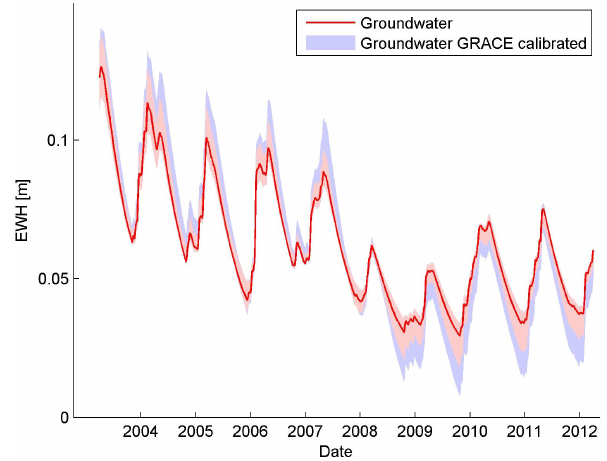
Figure 10. Water mass of groundwater reservoir smoothed over 10days, showing a permanent decline of groundwater between 2007 and 2009. The red line and bandwidth represent the Pareto ensemble based on the NS and log NS of streamflow, while the blue bandwidth shows the extension of the Pareto ensemble when the NS for water mass is added as a third